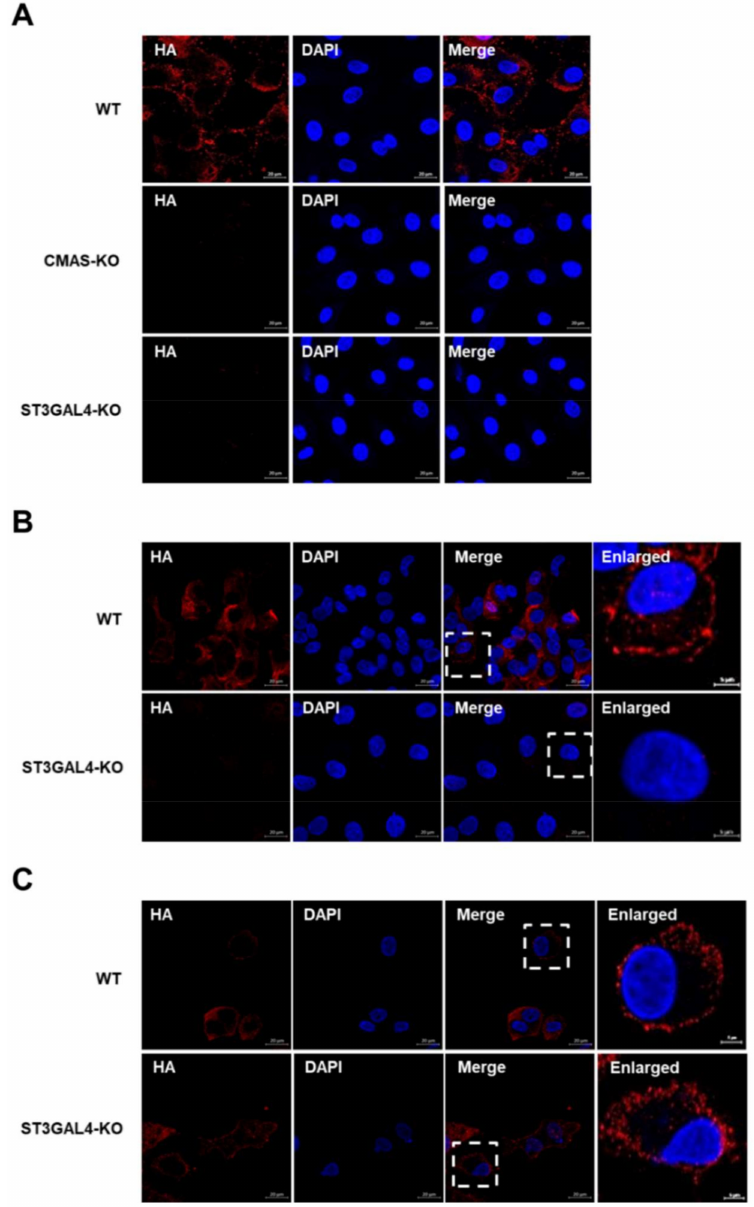
Figure 6. CMAS and ST3GAL4 are essential for IAVs attachment. CMAS -KO and ST3GAL4 -KO NPTr cells were generated through the CRISPR/Cas9 system; NPTR-Cas9 cells were used as wild-type control. ( A ) WT NPTr cells and KO NPTr cells were infected with Sw/HuB/H1N1 virus (MOI = 75) for 1 on ice and incubated with influenza virus HA protein antibody, then analyzed by fluorescent microscopy. Scale bar = 20 µ m. ( B , C ) The lack of ST3GAL4 mainly prevents the avian influenza virus attachment. ST3GAL4 -KO cells or control cells were infected with ( B ) H9N2 or ( C ) PR8 virus (MOI = 75) for 1 h on ice and analyzed by fluorescent microscopy. Scale bar = 20 µ m or 5 µ m. Since human IAVs mainly bind to α -2,6 sialic acid receptors and avian IAVs prefer to bind to α -2,3 sialic acid receptors, we compared the effect of ST3GAL4 knockout on the attachment of avian and human IAVs. The results showed that the knockout of ST3GAL4 had a significant effect on inhibiting the virus attachment of avian H9N2 subtype strains, while the effect on PR8 subtype strains was not too obvious (Figure 6B,C). This result was also consistent with our previous findings in virus titer and lectins